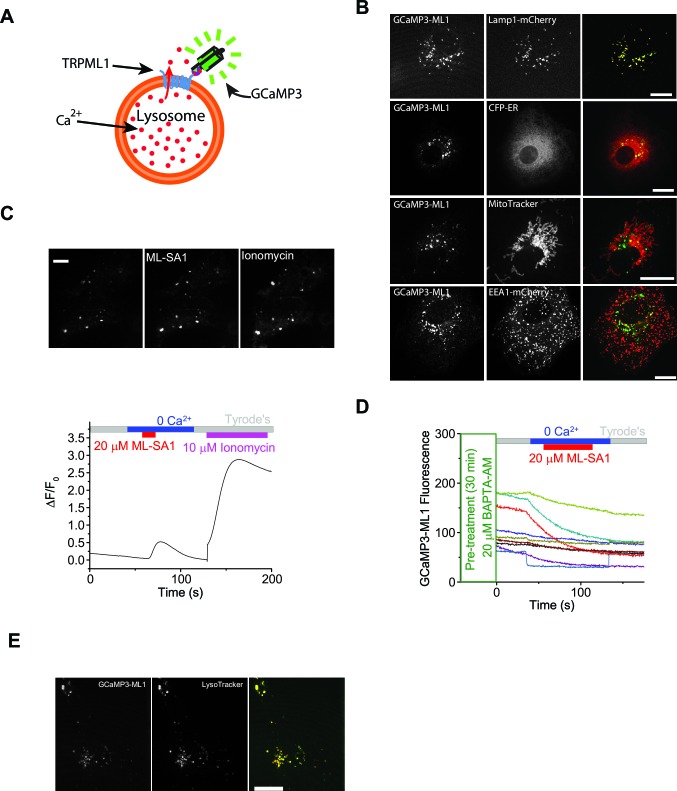
A lysosome-targeted genetically-encoded Ca2+ indicator to measure lysosomal Ca2+ release, store depletion, and refilling.(A) Detection of lysosomal Ca2+ release by a genetically-encoded Ca2+ indicator (GCaMP3) fused directly to the N-terminus of ML1 (GCaMP3-ML1). (B) Co-localization analyses between GCaMP3-ML1 and various organellar markers, including Lamp1-mCherry, CFP-ER, Mito-tracker, and EEA1-mCherry. Scale bars = 5 μm. (C) In an HEK-GCaMP3-ML1 cell, both ML-SA1 and subsequent ionomycin induced GCaMP3 fluorescence increases in lysosomes shown by both fluorescence imaging and Ca2+ imaging. (D) BAPTA-AM pre-treatment abolished ML-SA1-induced responses in HEK-GCaMP3-ML1 cells. Panel C shows the average response of 30–40 cells from one representative experiment. (E) Cos7 cells transfected with GCaMP3-ML1 show strong co-localization with LysoTracker, which is highly selective for acidic organelles.